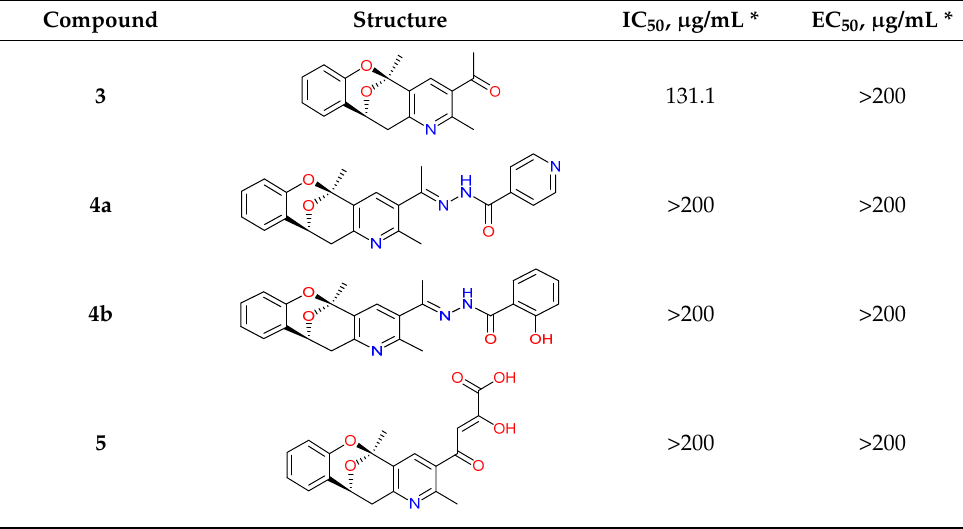
Table 1. Cytotoxicity and antiviral activity against SARS-CoV-2 in Vero E6 cells. Compound